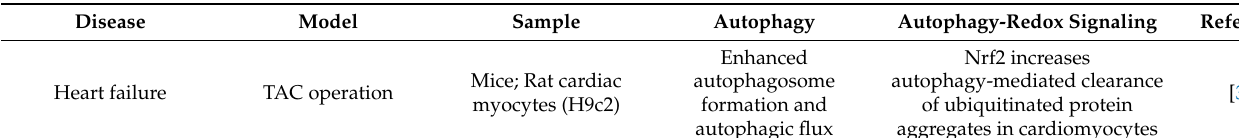
Table 1. Interplay between autophagy and Nrf2 in cardiovascular